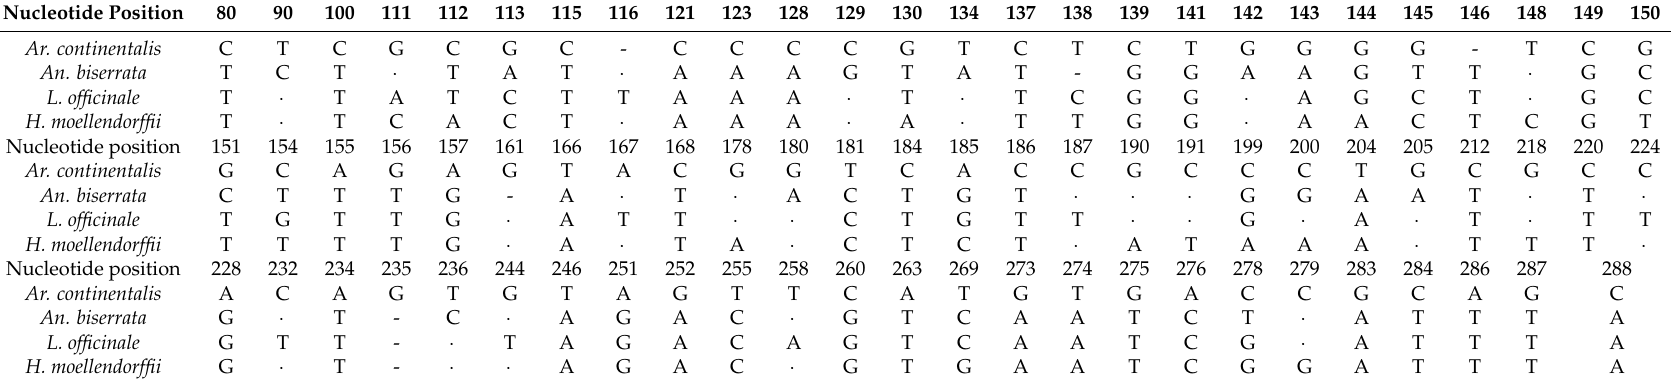
Table 3. Summary of species-specific indels and nucleotide substitutions in the ITS2 DNA barcode region of Ar. continentalis and closely related medicinal plant